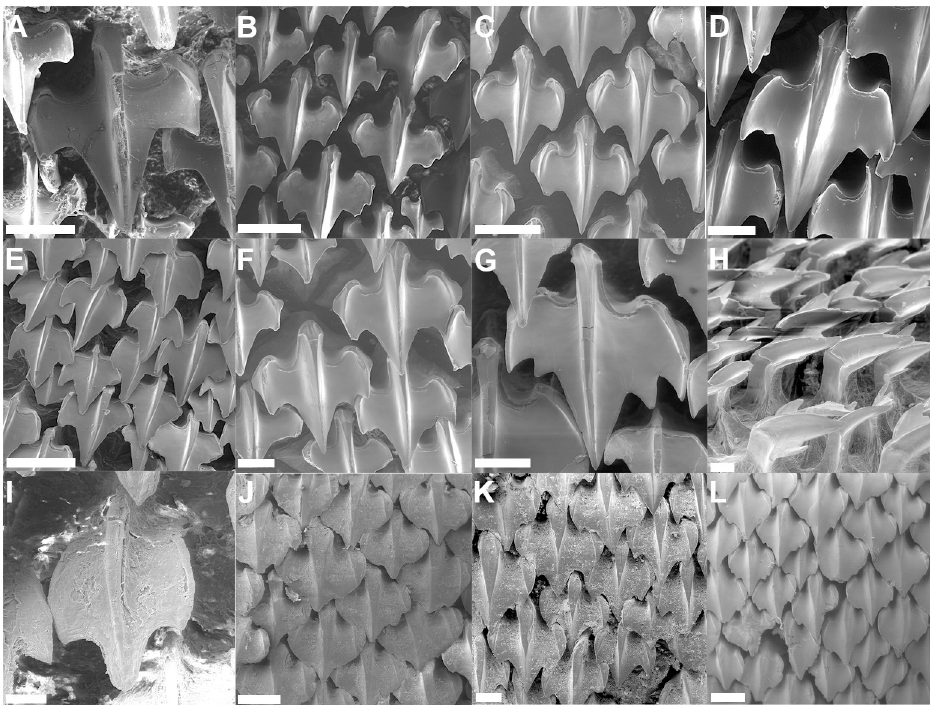
Fig 12. Scanning electron microscopy of dermal denticles of species of Cirrhigaleus in coronal (A–L, except H) and lateral (H) views. C . barbifer (A–C): A: HUMZ 197852 (neotype), adult female, 870 mm TL; B: NMW 98257, adult female, 960 mm TL; C: CSIRO H 5875–09, adult female, 978 mm TL; C . australis (D–H): D: NMNZ P 38074, adult male, 1020 mm TL; E: NMNZ P 42489, juvenile male, 710 mm TL; F: CSIRO H 7048–01, adult male, 993 mm TL; G–H AMS I 45670–001, juvenile male, 630 mm TL. C . asper (I–L): I: SAIAB, 6092, juvenile female, 275 mm TL; J: SAIAB 31890, adult female, 1090 mm TL; K: SAM 39879, adult female, 1023 mm TL; L: NUPEC uncatalogued, adult